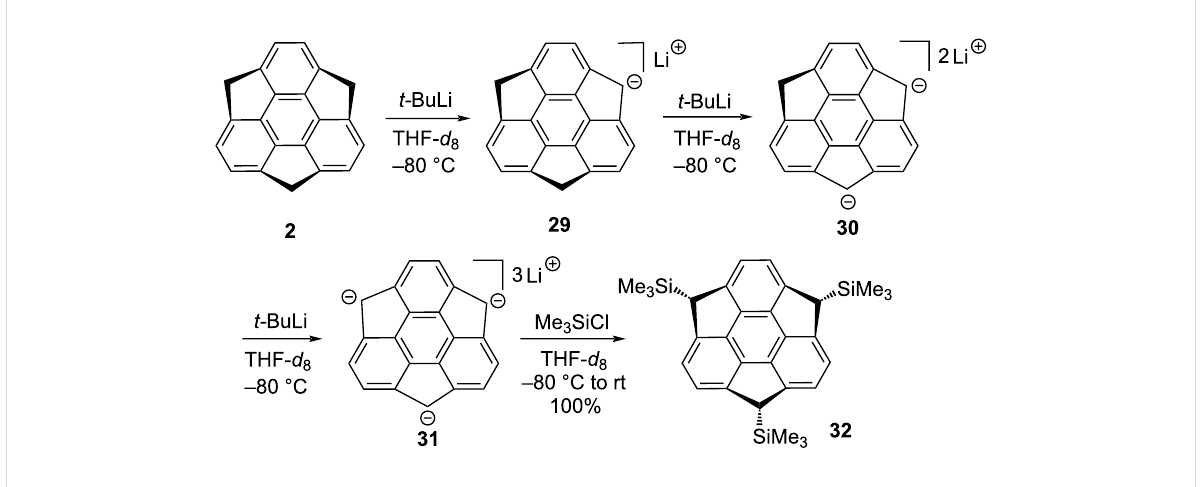
Scheme 4: Generation of anions 29–31 and the preparation of tris(trimethylsilyl)sumanene 32 .